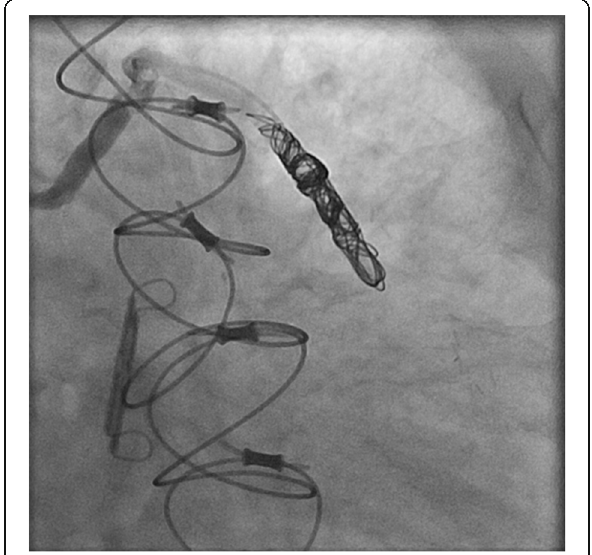
Fig. 2 An angiographic image of successful coiling of the aortocoronary